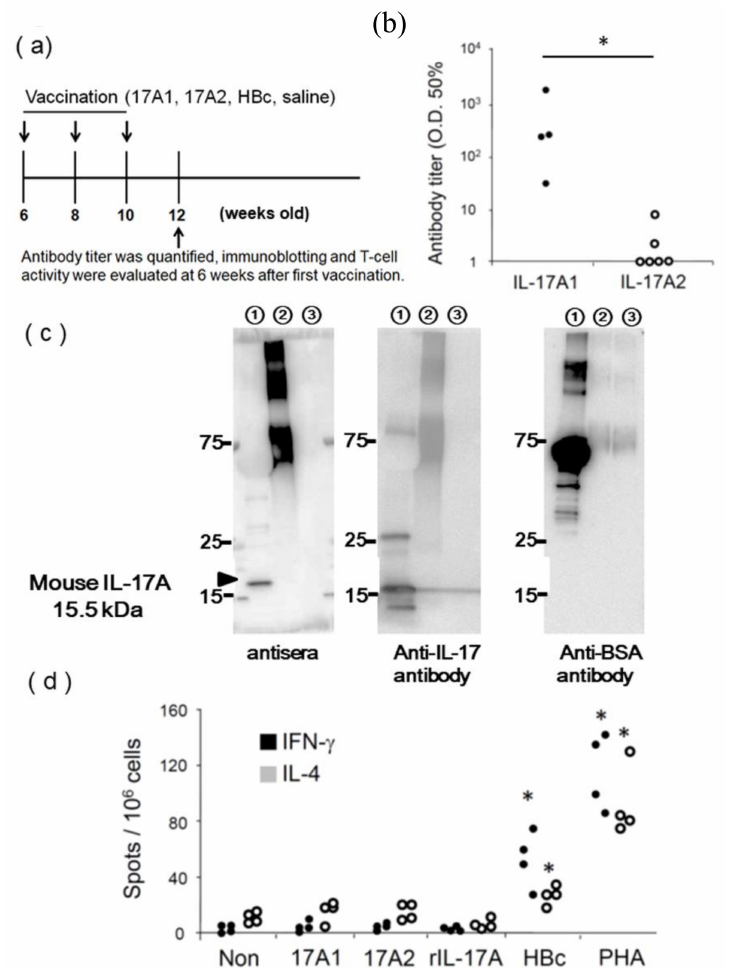
Figure 2. Evaluation of anti-IL-17A antibodies induced by IL-17A vaccination in BALB / c mice; ( a ) Female BALB / c mice were immunized with pcDNA3.1-HBc-IL17A1 (IL-17A1), pcDNA3.1-HBc-IL17A2 (IL-17A2), pcDNA3.1-HBc (HBc), or saline via intramuscular administration using an electroporator three times at two week intervals. We collected serum from immunized mice, and antibody titers were measured by ELISA at 6 weeks after the first vaccination (12 weeks old). Immunoblotting and T-cell activity assays were also performed using serum from 12-weeks-old mice. ( b ) The anti-IL-17A1 antibody titer (OD 50 %) was increased, but the anti-IL-17A2 titer was not ( n = 6). ( c ) (left panel) Antisera from IL-17A1 immunized mice detected an IL-17A1-BSA conjugate and recombinant mouse IL-17A, but not an IL-17A2-BSA conjugate. (middle panel) A commercially available anti-IL-17A antibody also detected recombinant mouse IL-17A. (right panel) An anti-BSA antibody detected BSA, but not recombinant mouse IL-17A. Lane 1, recombinant mouse IL-17A with BSA; lane 2, IL-17A1-BSA conjugated peptide; and lane 3, IL-17A2-BSA conjugated peptide. ( d ) In an ELISPOT assay, splenocytes (10 6 cells per well) from IL-17A1-immunized mice at 12 weeks of age were stimulated with 17A1 peptide, 17A2 peptide, recombinant mouse IL-17A (rIL-17A), HBc peptide, or PHA at 10 µ g / mL. The production of IFN- γ or IL-4 by splenocytes was detected as black spots. The splenocytes of six mice were tested in the ELISPOT assay. The number of spots was quantified in triplicate wells of each group. * p < 0.05 vs no